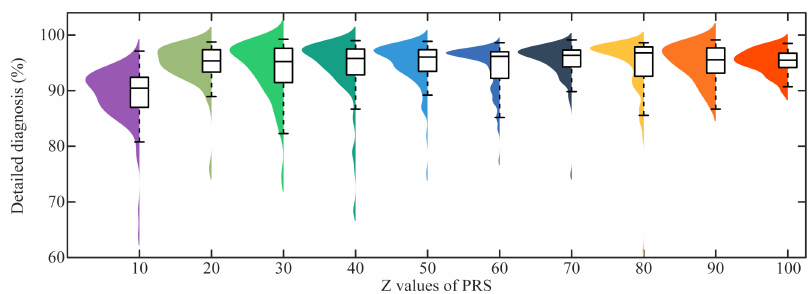
Figure 14. The sensitivity of diagnostic accuracy of the DAPRN to the Z values of